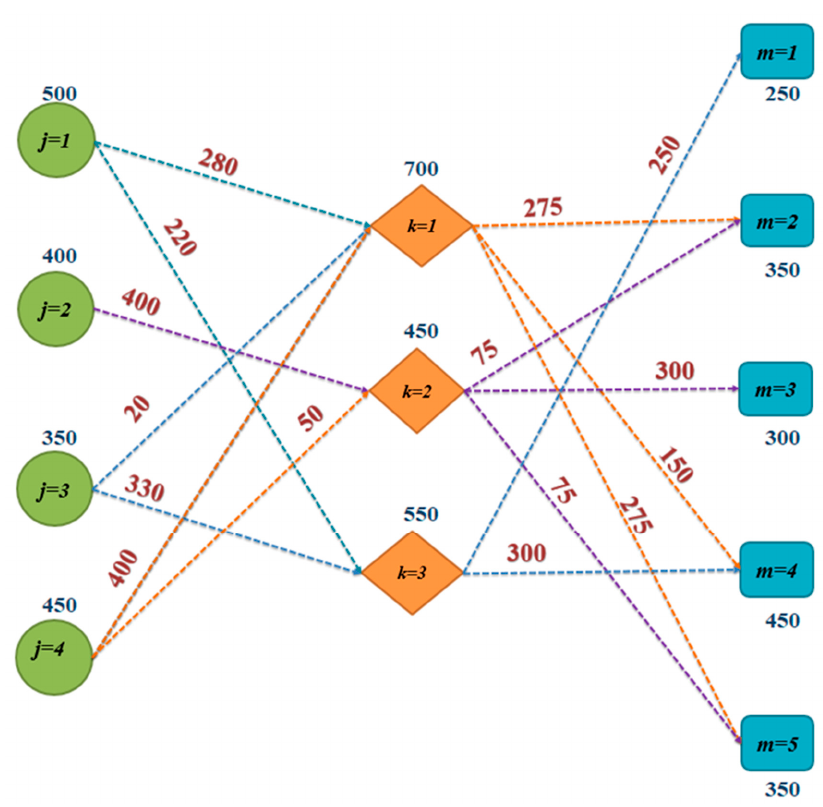
Figure 3. Optimal transmission policy.